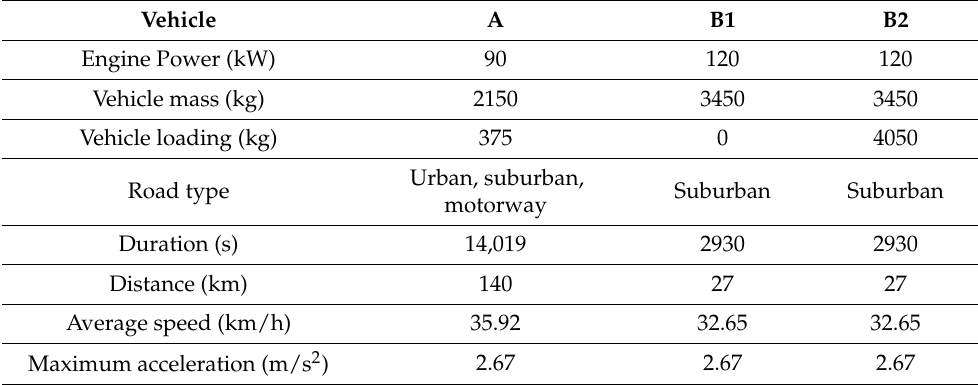
Table 1. Drive cycle characteristics of each tested vehicles. Reprinted from ref. [13], Copyright (2020), with permission from